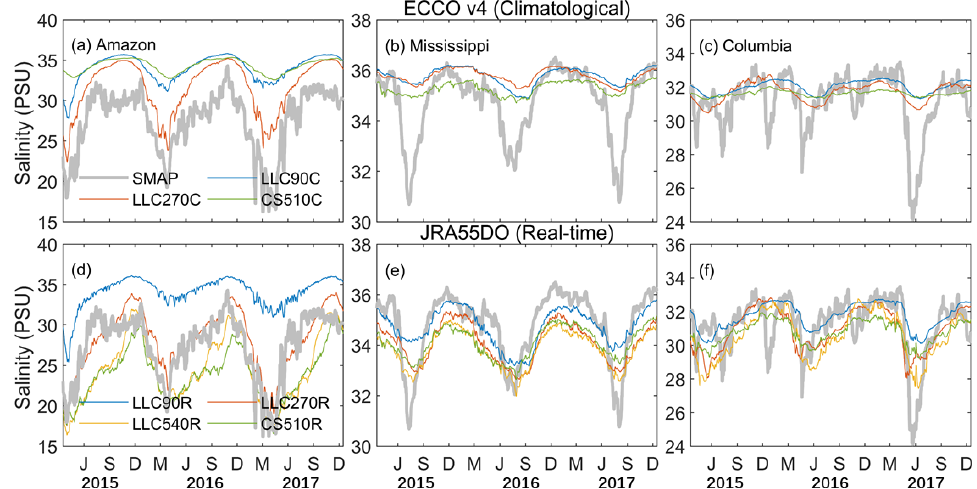
Figure 3. Areally averaged SSS in the Amazon, Mississippi, and Columbia river mouth regions (see Fig. S3) with climatological diffusive and daily, point-source runoff forcing for SMAP (thick gray line) and experiments (thin colored lines) with varying horizontal grid resolution. The method used to characterize the river mouth region is described in Sect.